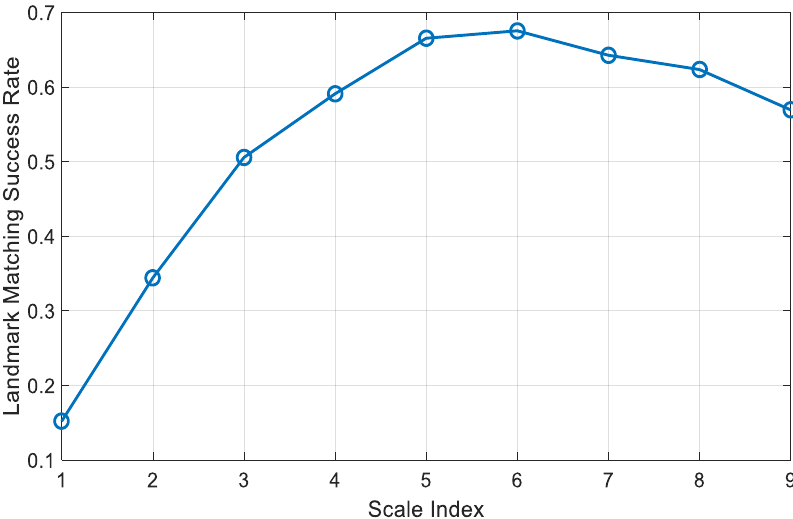
Figure 9. Landmark matching success rate with respect to landmark scales based on bi-directional nearest neighbor search between the “day-left” and “night-right” sequences.